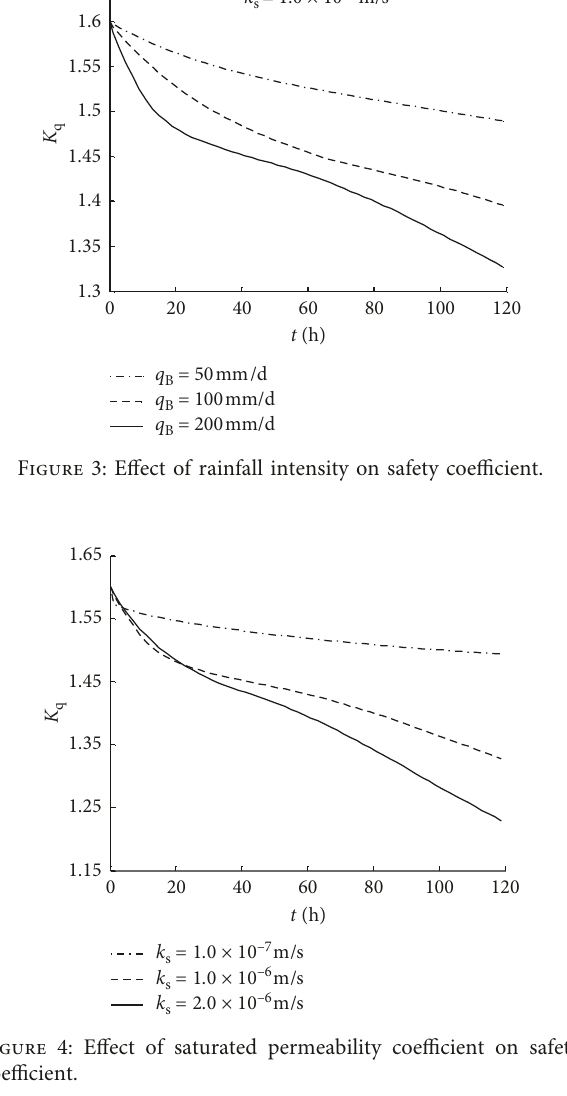
(a) The same water table on both sides. (b) The different water table on both